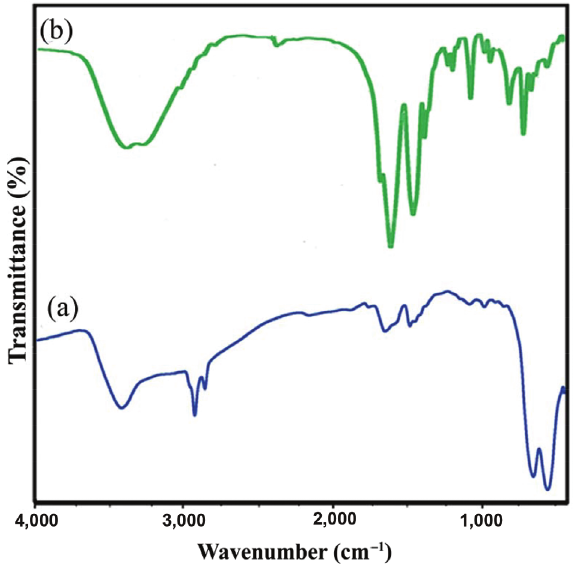
Figure 2: FT-IR spectra of (a) MnOOH (sample no. 1) and (b) [Mn(Hsal) 2 ]